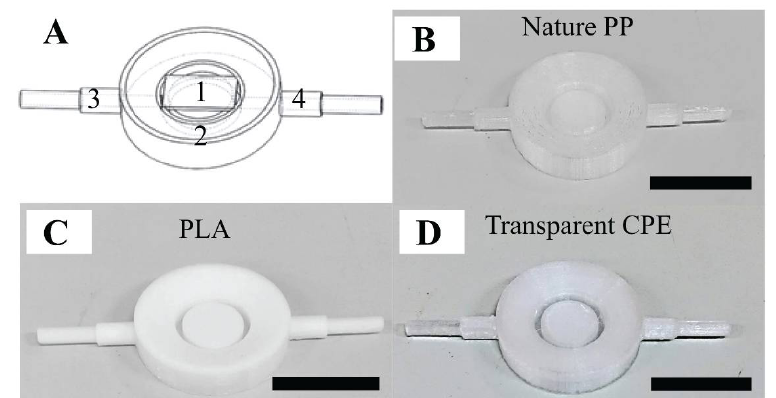
Figure 1. The performance of the 3D-printed fluid cell: ( A ) blueprint of the fluid cell: part (1) a glass substrate placed on top of the sample substrate holder, part (2) the ring of the fluid cell, and parts (3–4) two symmetrical pipes, and ( B , C , D ) fluid cell products involving nature polypropylene (PP), polylactic acid (PLA), and transparent copolyester (CPE), respectively. The scale bar is 1 cm.